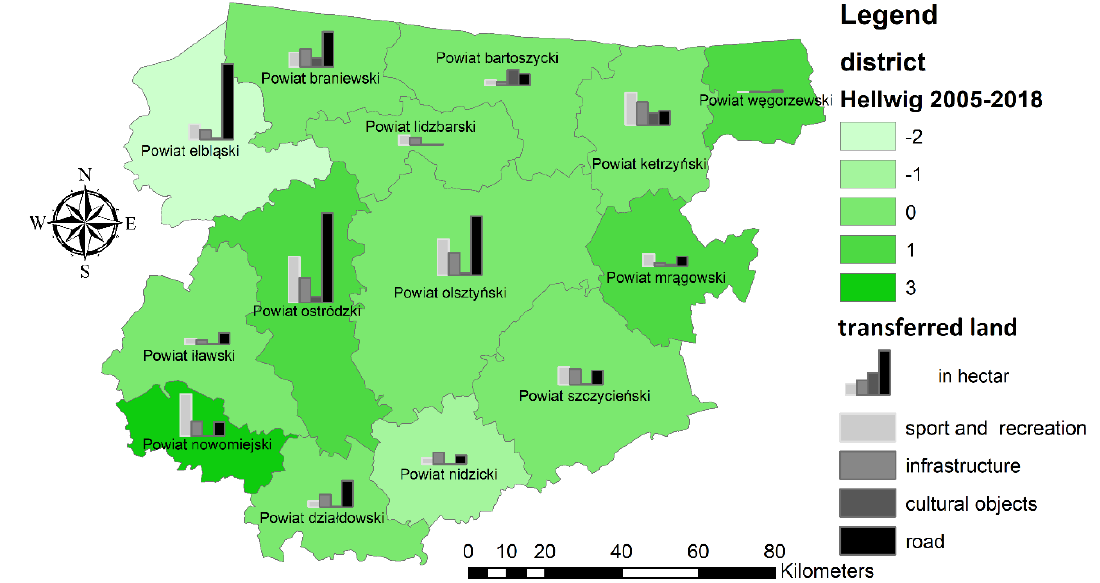
Figure 6. Change in the social development classes in the period 2005-2018 compared to the area of land transferred for various purposes. Data for districts. Table 4. Pearson correlation coefficient values for all analysis variants/districts.